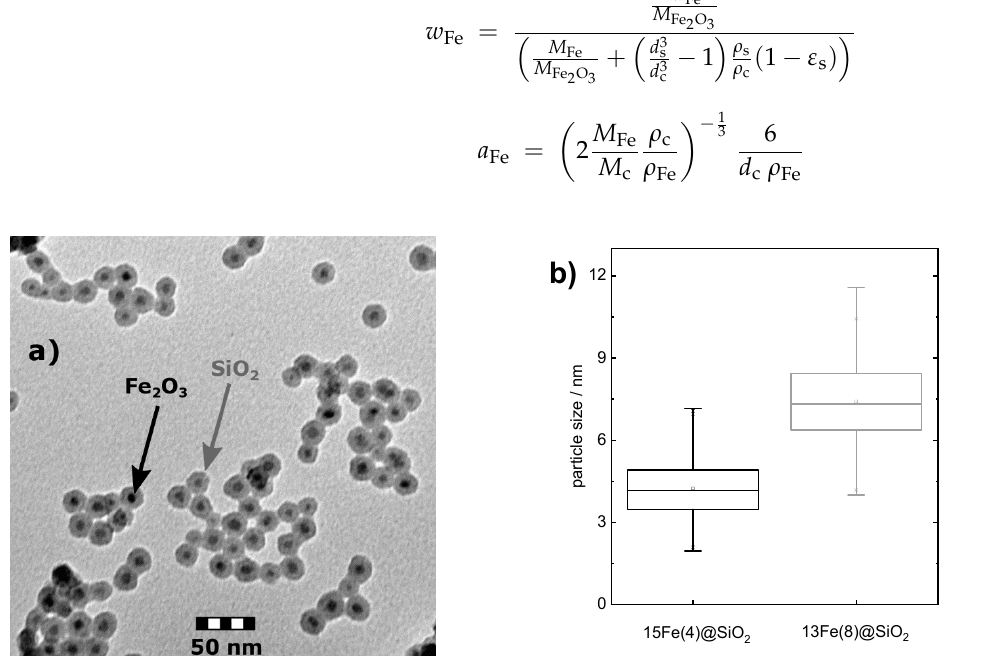
Figure 3. ( a ) TEM micrograph of 13Fe(8)@SiO 2 core-shell particles (as-made), ( b ) box-plots of particle size distribution of selected core-shell particles calculated from TEM Table 3. Average core size (cid:1856) ̅ (cid:2913)(cid:2925)(cid:2928)(cid:2915) of as-made Fe@SiO 2 core-shell particles and the respective SiO 2 shell thickness (cid:1856) ̅ (cid:2929)(cid:2918)(cid:2915)(cid:2922)(cid:2922) measured from TEM micrographs: iron (cid:1875) (cid:2890)(cid:2915) content and specific surface area (cid:1853) (cid:2890)(cid:2915) calculated from measured values via Equations (2) and (3).